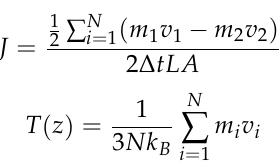
Figure 6. Schematic diagram of RNEMD model.